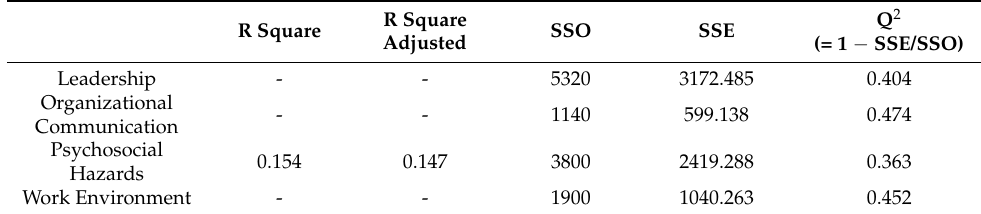
Table 7. R2 and Construct Cross validated Communality Q 2